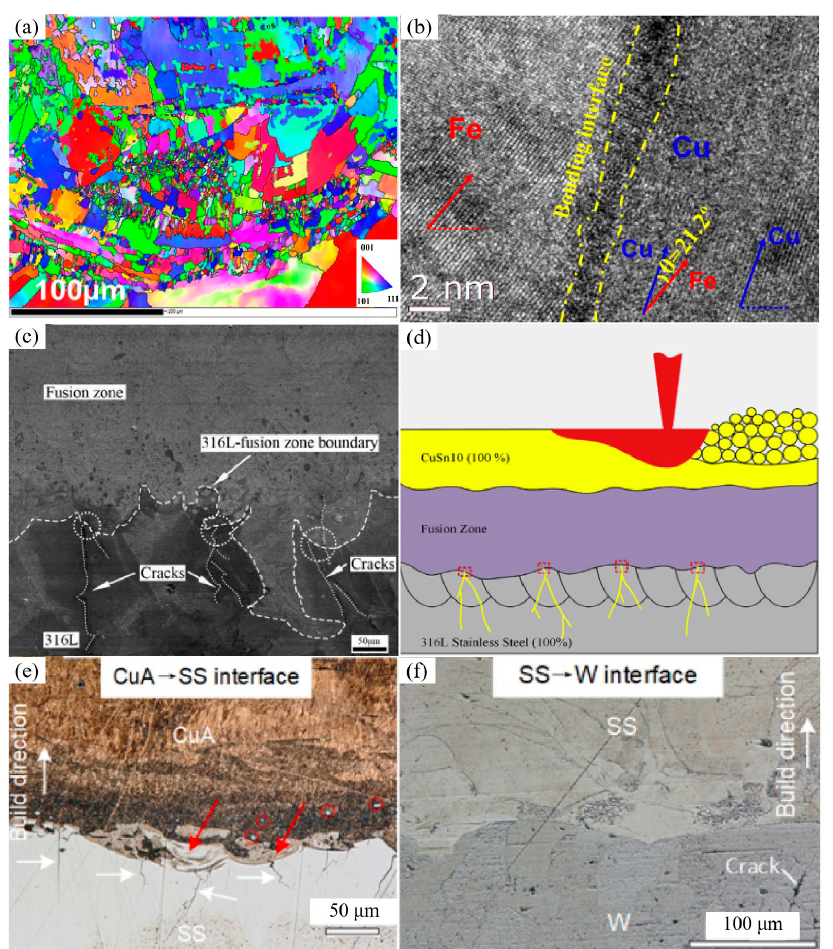
Figure 6. ( a ) Inverse pole figure of interfacial microstructure; ( b ) High-resolution transmission electron microscope (HRTEM) image of the bonding interface; ( c ) Crack distribution in the fusion zone; ( d ) Schematic diagram of the dendritic cracks; ( e ) The interface of CuA/316L, red arrows representing elemental mixing, white arrows representing cracks; ( f ) Interface of 316L/W [94,103,104].